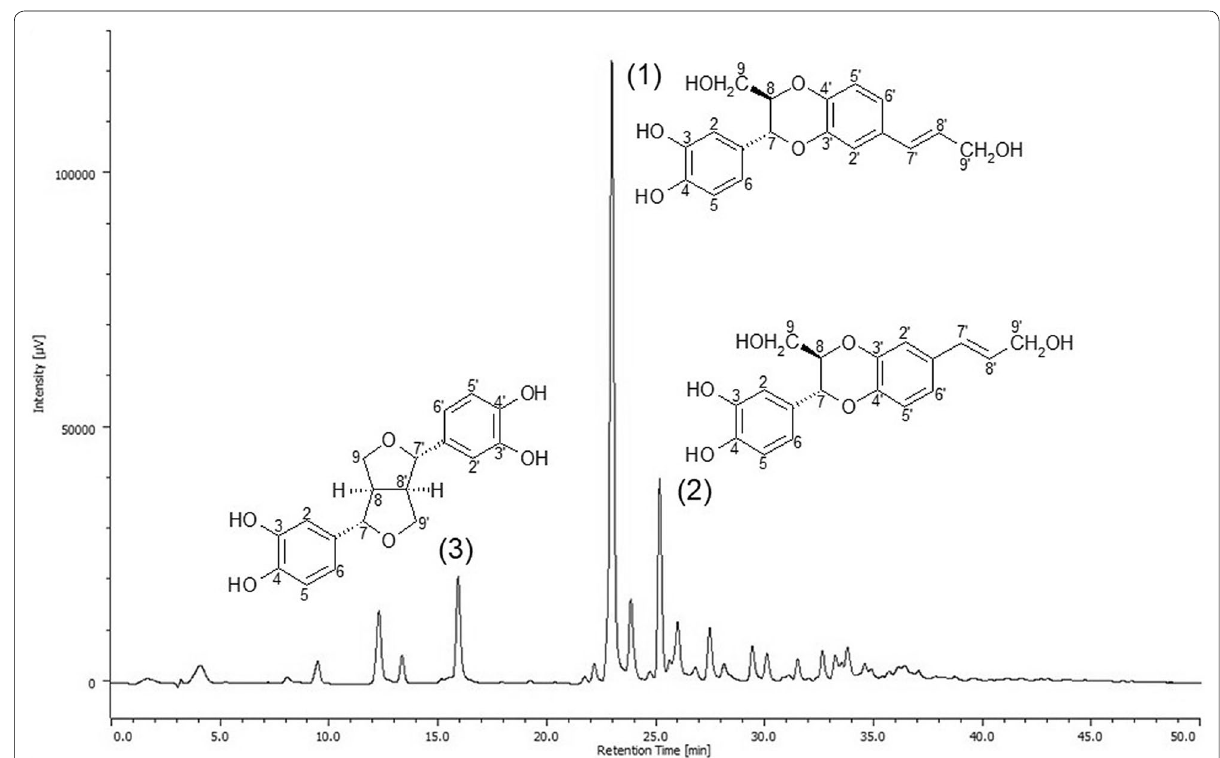
Fig. 3 HPLC chromatogram (UV 254 nm) of the methanol extract of a whole tung seed. (1) Isoamericanol A, (2) americanol A, and (3) 3,3 ′